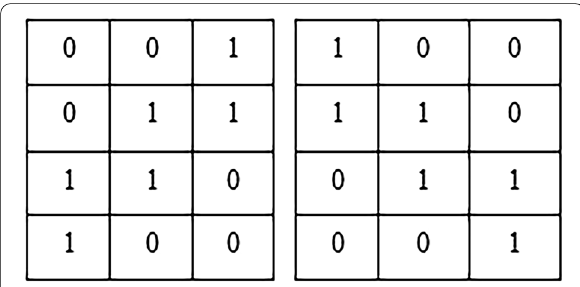
Figure 7 Morphological operators of the closed operation for inner and outer lower crack of screw